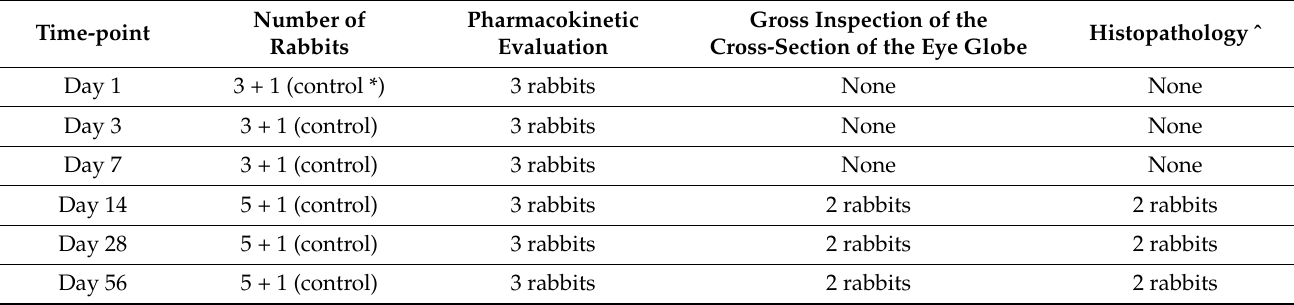
Figure 1. Optical microscopy images of the PLGA-coated CS-MTX micro-implant showing the top view ( A ) and the cross-sectional view ( B ). The microstructure of the micro-implant can be observed in the SEM images showing the top view ( C ) and the cross-sectional view ( D ). Table 1. Design of the minimally invasive